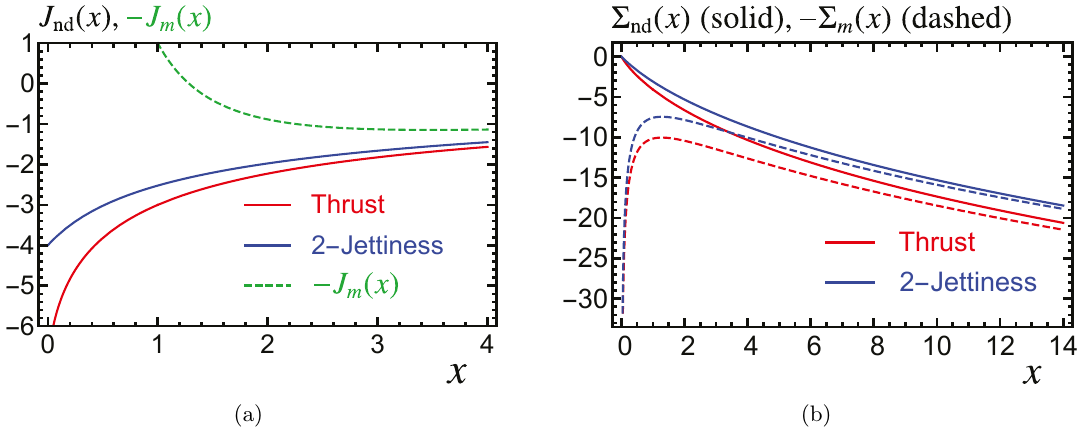
Figure 5 . Massive corrections to the jet function. Panels (a) and (b) show the di(cid:11)erential and cumulative jet functions, respectively. We show with solid lines the non-distributional functions J nd and (cid:6) nd for P- (red) and M- (blue) schemes. The di(cid:11)erential J m function is shown multiplied (cid:0) 1 as a green dashed line in panel (a) (for x > 0 it is common to both schemes), while (cid:0) (cid:6) m is shown in panel (b) with red and blue dashed lines for P- and M-schemes,